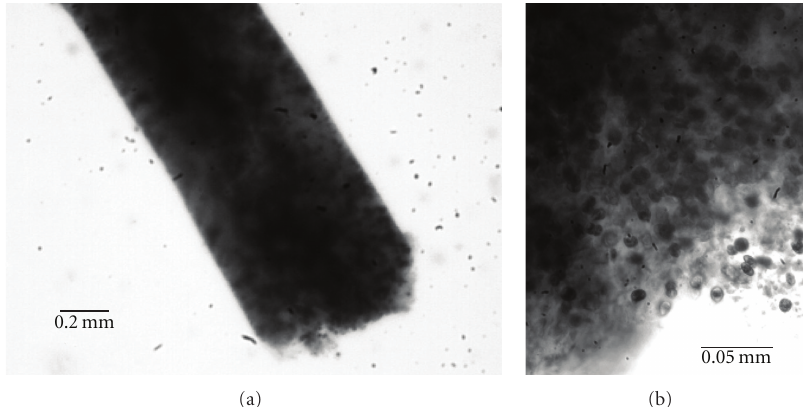
Figure 7: Mytilus edulis . (a) String of faeces from a 36.6 mm shell length mussel fed algal cells ( Rhodomonas salina ) at a concentration of 20,000 cells mL − 1 . (b) Closeup of faeces revealing closely packed undigested algal